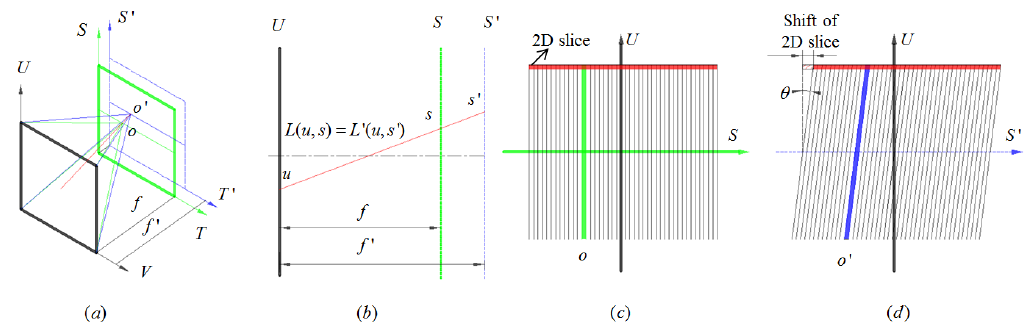
Figure 3. The principle of digital refocusing based on two ‐ plane parametrization of light field. ( a ) Refocusing denoted by two ‐ plane parametrization; ( b ) Representing the four ‐ dimensional (4D) light field by 2D ( u , s ); ( c ) Sampling of radiance before refocusing which focus on ST plane; and, ( d ) Sampling of radiance after refocusing which focus on S ′ T ’ plane.